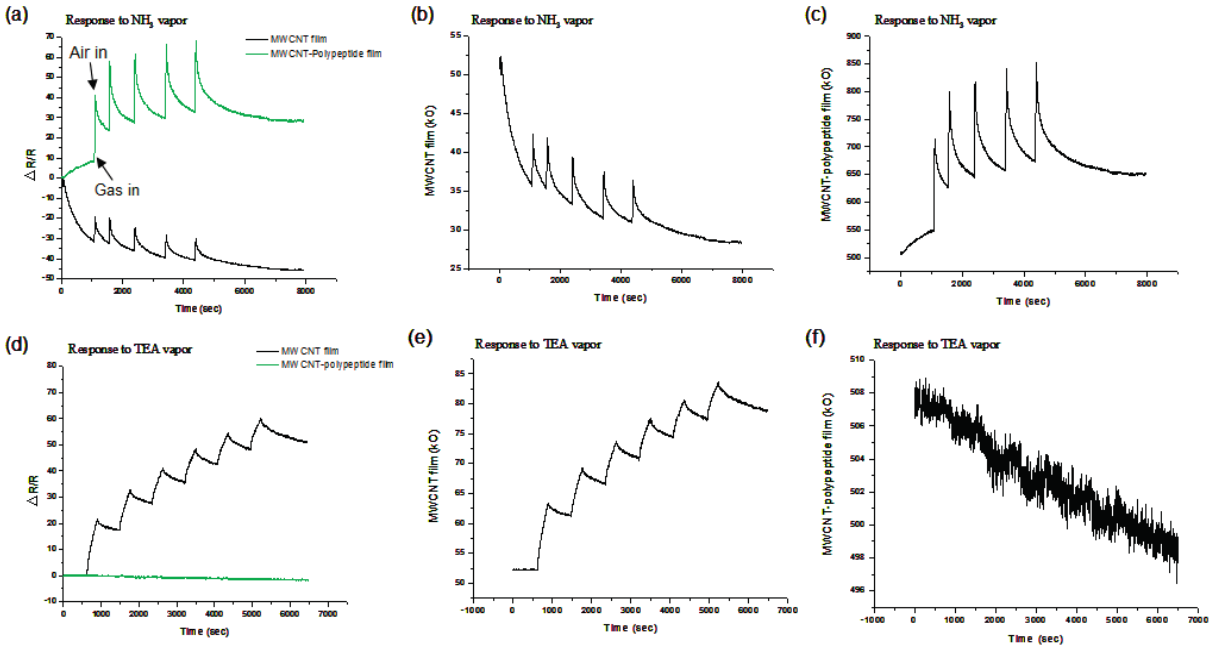
Figure 6. Gas sensing responses to NH 3 gas (283 ppmv) of ( a ) MWCNT films and MWCNT-polypeptide composite films; ( b ) MWCNT films; and ( c ) MWCNT-polypeptide composite films, and gas sensing responses to triethylamine (2166 ppmv) of ( d ) MWCNT films and MWCNT-polypeptide composite films; ( e ) MWCNT films; and ( f ) MWCNT-polypeptide composite